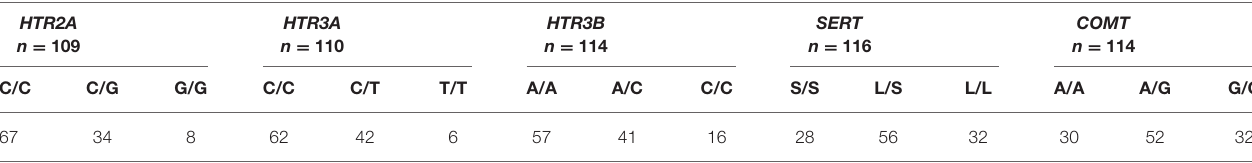
TABLE 2 | The distribution of HTR2A (rs9316233) , HTR3A (rs1062613) , HTR3B (rs1176744) , SERT (5-HTTLPR) and COMT (rs4680) genotypes in 117 patients with TMD myalgia (16 men and 101 women). HTR2A n =